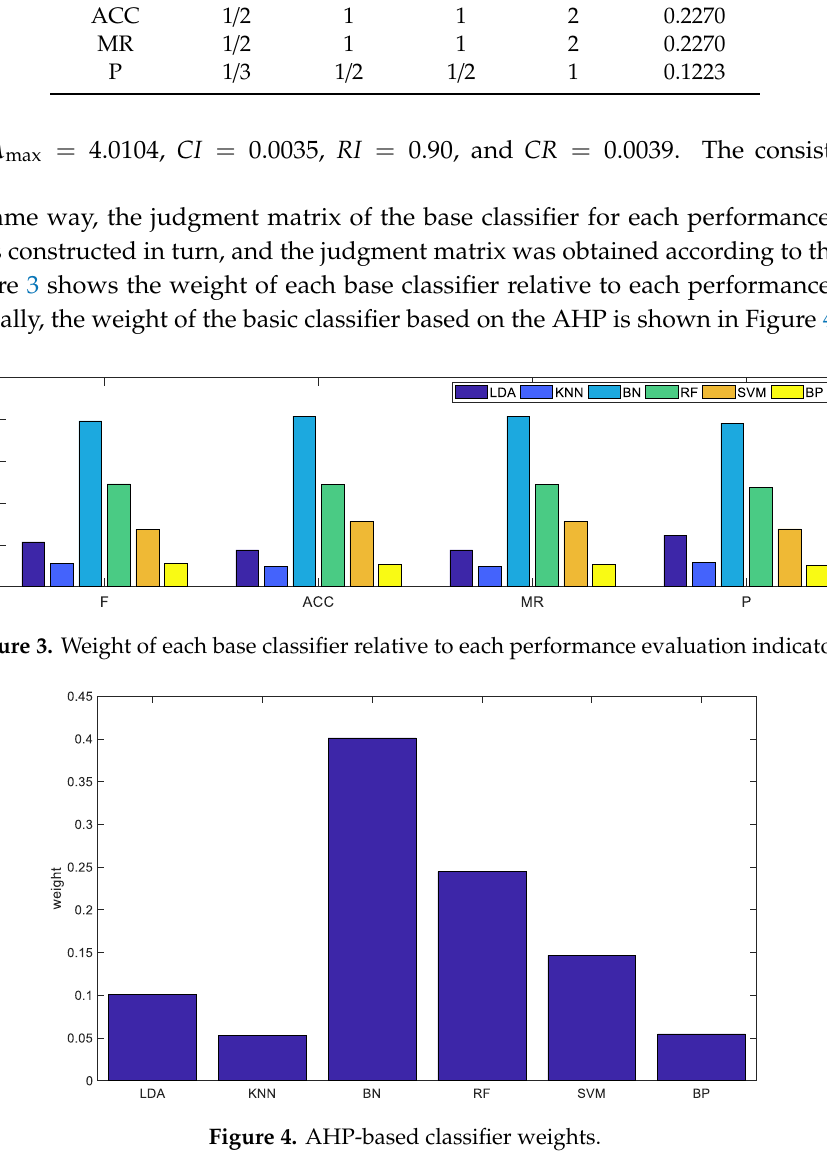
Figure 5. Value of each base classifier relative to each performance evaluation indicator